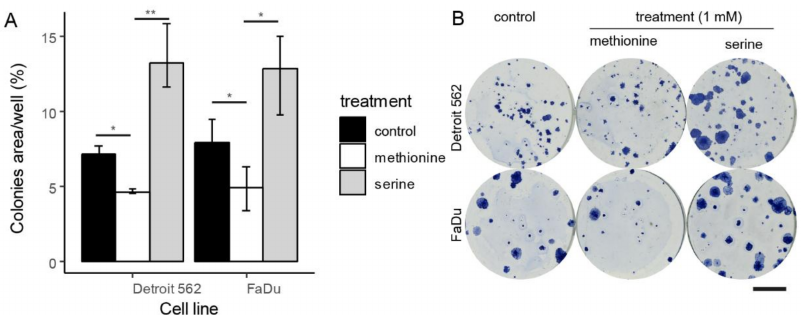
Figure 2. Colony-forming assays, in vitro cell line experiment on head and neck squamous cell cancer (HNSCC) primary (FaDu) and secondary (Detroit 562) cell lines. Shown area percentage of well area covered by cells after treatment in concentration 500 cells / well. ( A ) displayed as median and interquartile range, * indicate p < 0.05, ** p < 0.001 ( B ) representative wells, calibration chart denotes 10